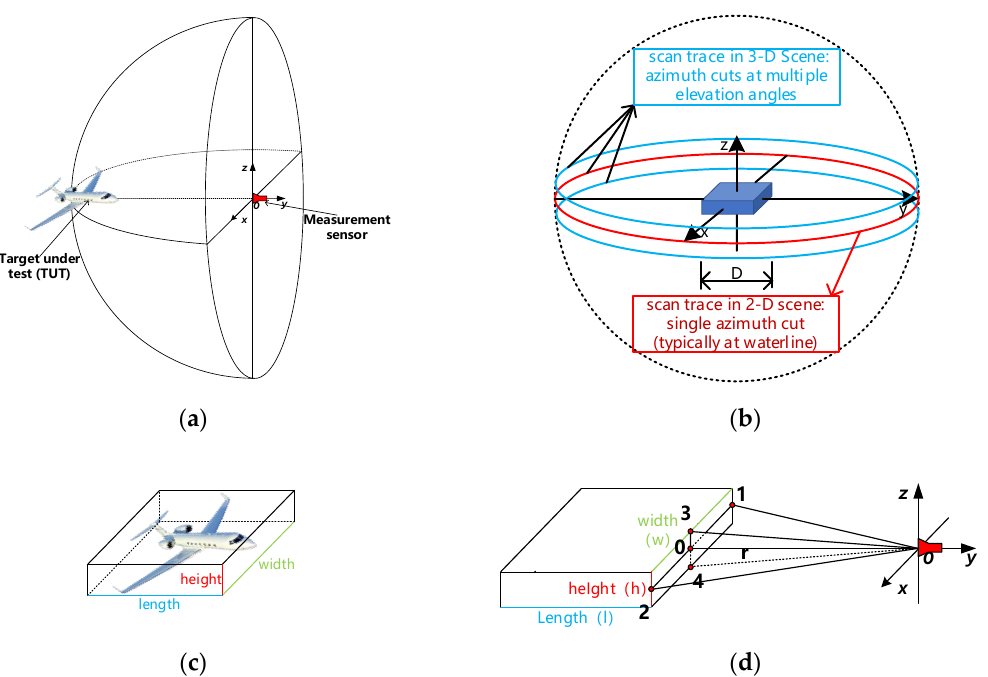
Figure 1. Schematic diagram for radar cross section measurement: ( a ) Incident spherical wave in the target under test (TUT); ( b ) Near-field scattering data collection geometries; ( c ) The geometry of the TUT; ( d ) Incident wave analysis of the TUT.